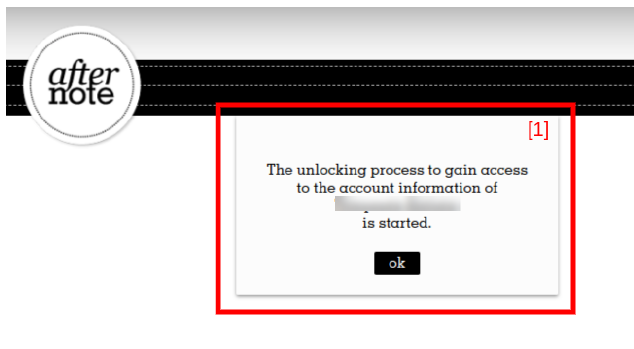
Fig. 18. Afternote message to unblock the user’s account. Image adapted from